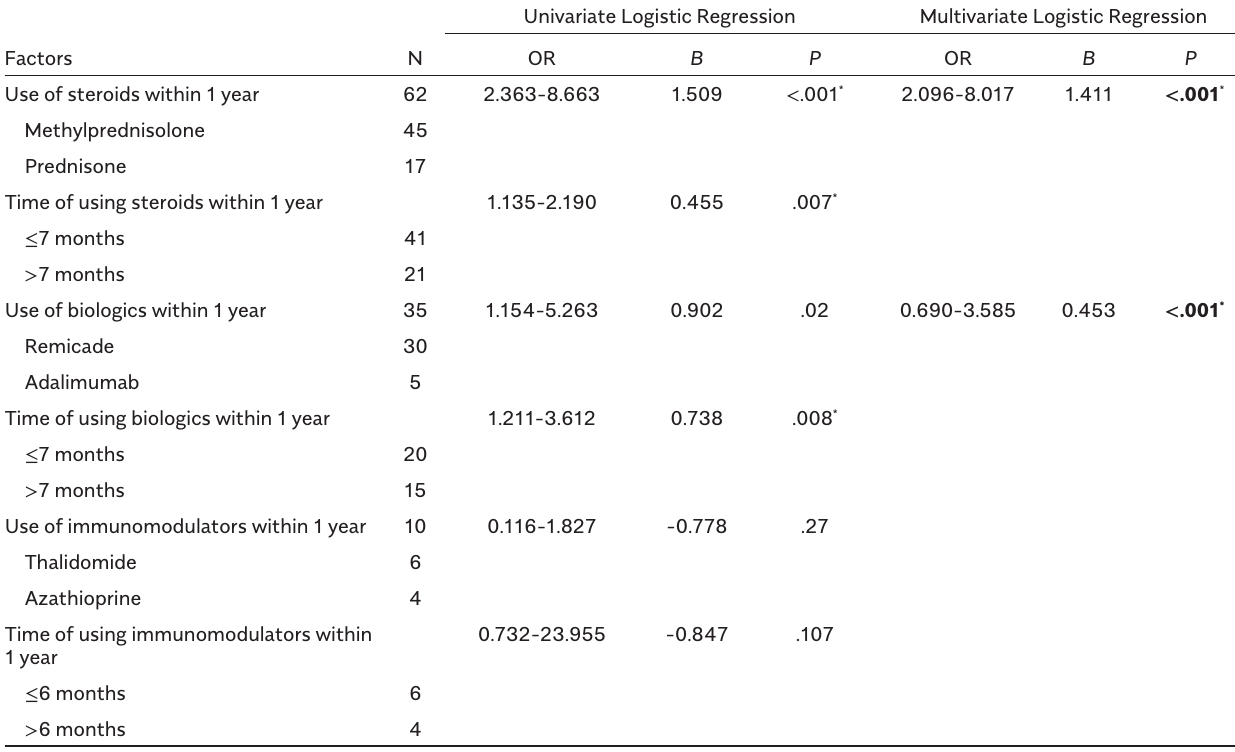
Table 4. Univariate and Multivariate Logistic Regression of Using of Hormones or Biologics or Immunomodulators Within 1 Year on Readmission Within 1 Year